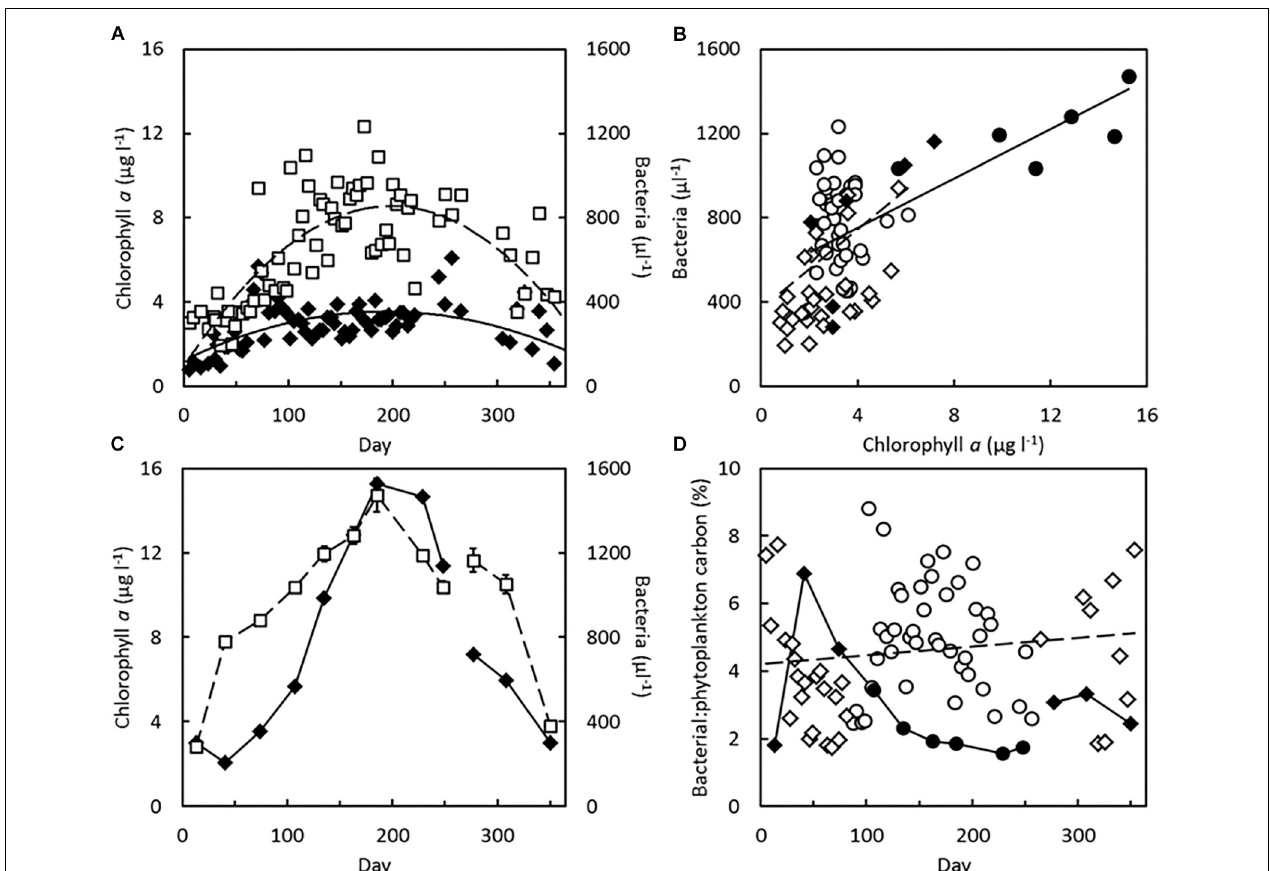
FIGURE 1 | (A,C) Chlorophyll a ( (cid:7) , —) and bacterial ( (cid:3) , —) concentrations in the water column measured over 1-year periods. (A) Inlet to Kerteminde Fjord, January 28, 2016 to January 30, 2017. Data redrawn from Lüskow et al. (2019), curves drawn by eye. (C) Frederik den VII’s Kanal, October 4, 2016 to September 5, 2017. Error bars indicate SEM of three samples. (B) Relationship between concentrations of bacteria and chlorophyll a in the inlet to Kerteminde Fjord